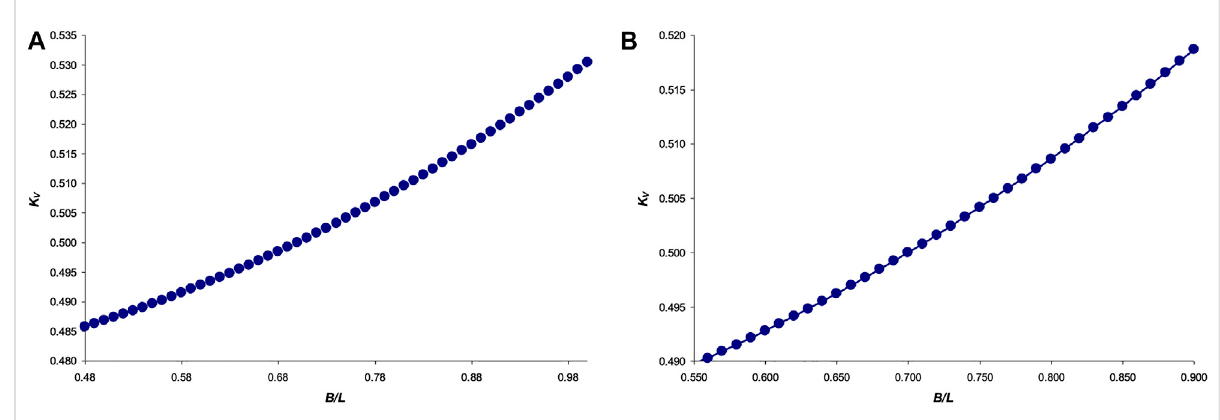
FIGURE 4 Graphical dependence of the function K V = f ( B / L ) for the interval: (A) B / L = [0.48 ... 1]; and (B) B / L = [0.55 ...